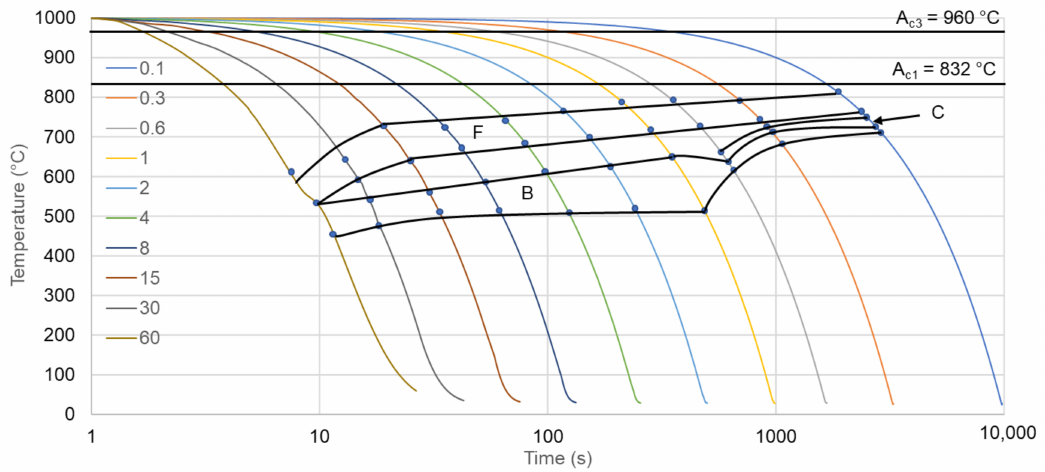
Figure 9. Experimental CCT diagram for analyzed steel. F—ferrite, B—bainite,